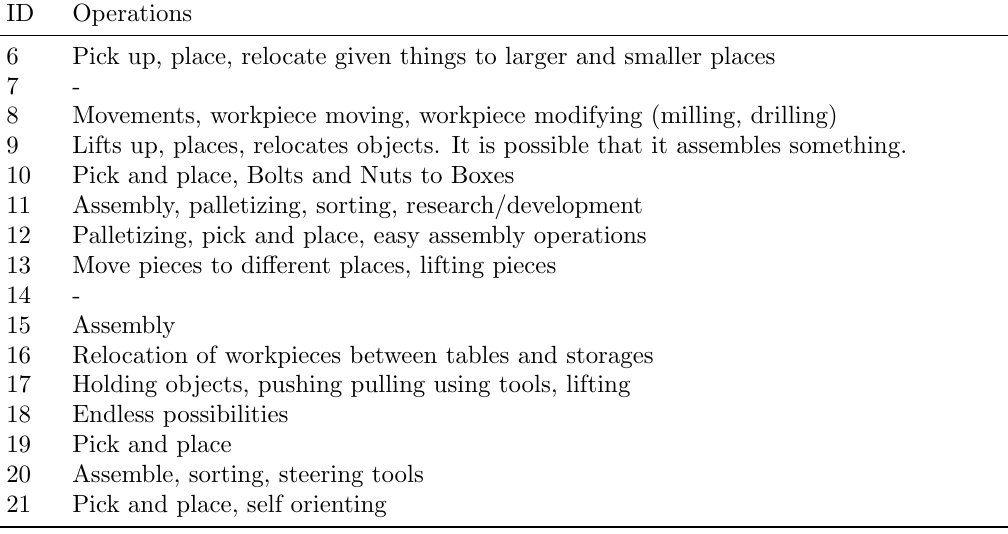
Table 2: Possible operations described by participants’ own